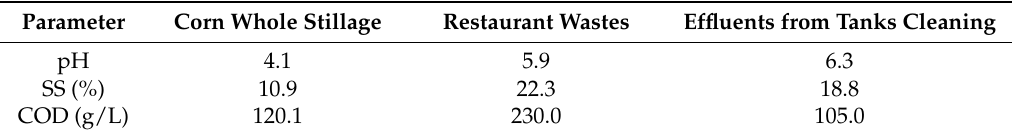
Table 3. Feedstocks